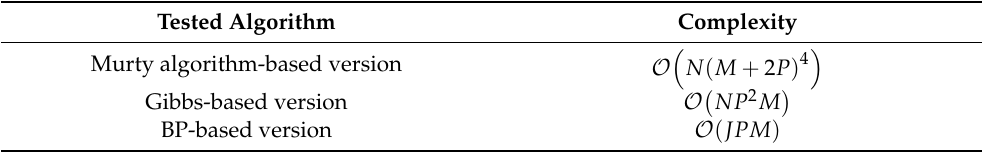
Table 1. The complexity of the tested